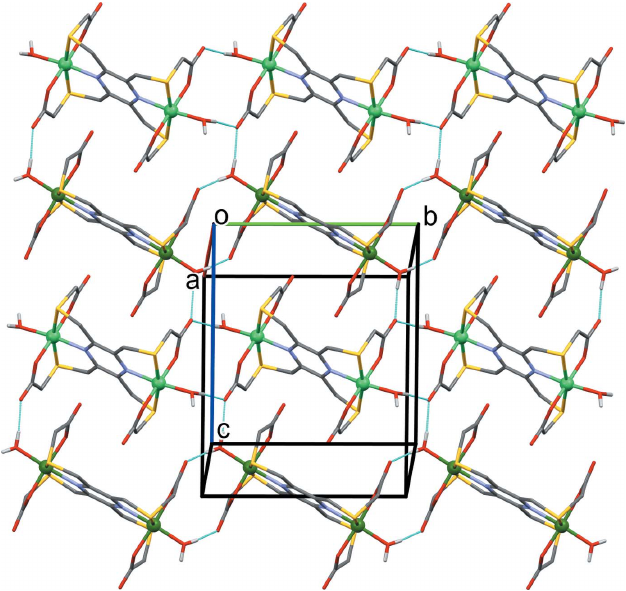
Figure 3 A view normal to the (101) plane of the crystal packing of the two independent molecules of complex I (atom Ni1 light-green ball; atom Ni2 dark-green ball). Hydrogen bonds (see Table 2) are shown as dashed lines. For clarity, solvent water molecules and C-bound H atoms have been